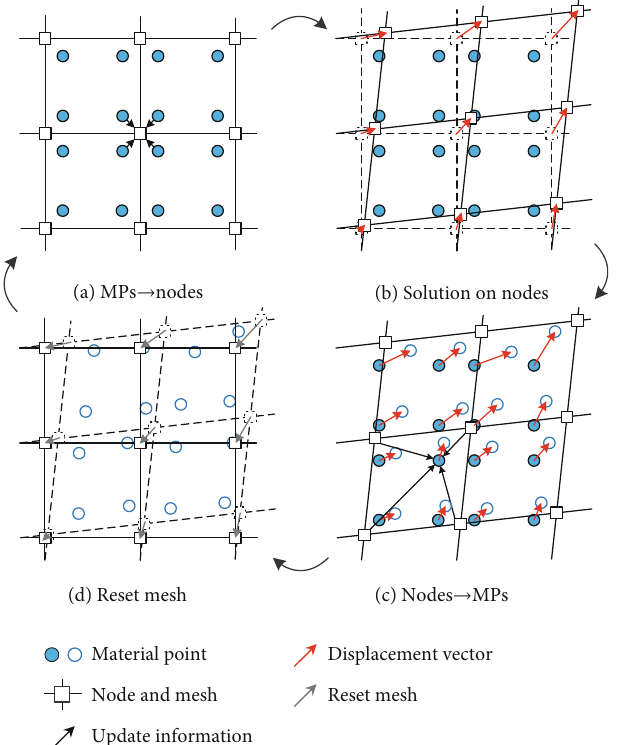
Figure 1: Computational cycles of MPM: (a) map MP info to nodes, (b) solve equilibrium equations on nodes and update nodes ’ info and positions, (c) map node info to MPs and update MPs ’ info and positions, and (d) reset